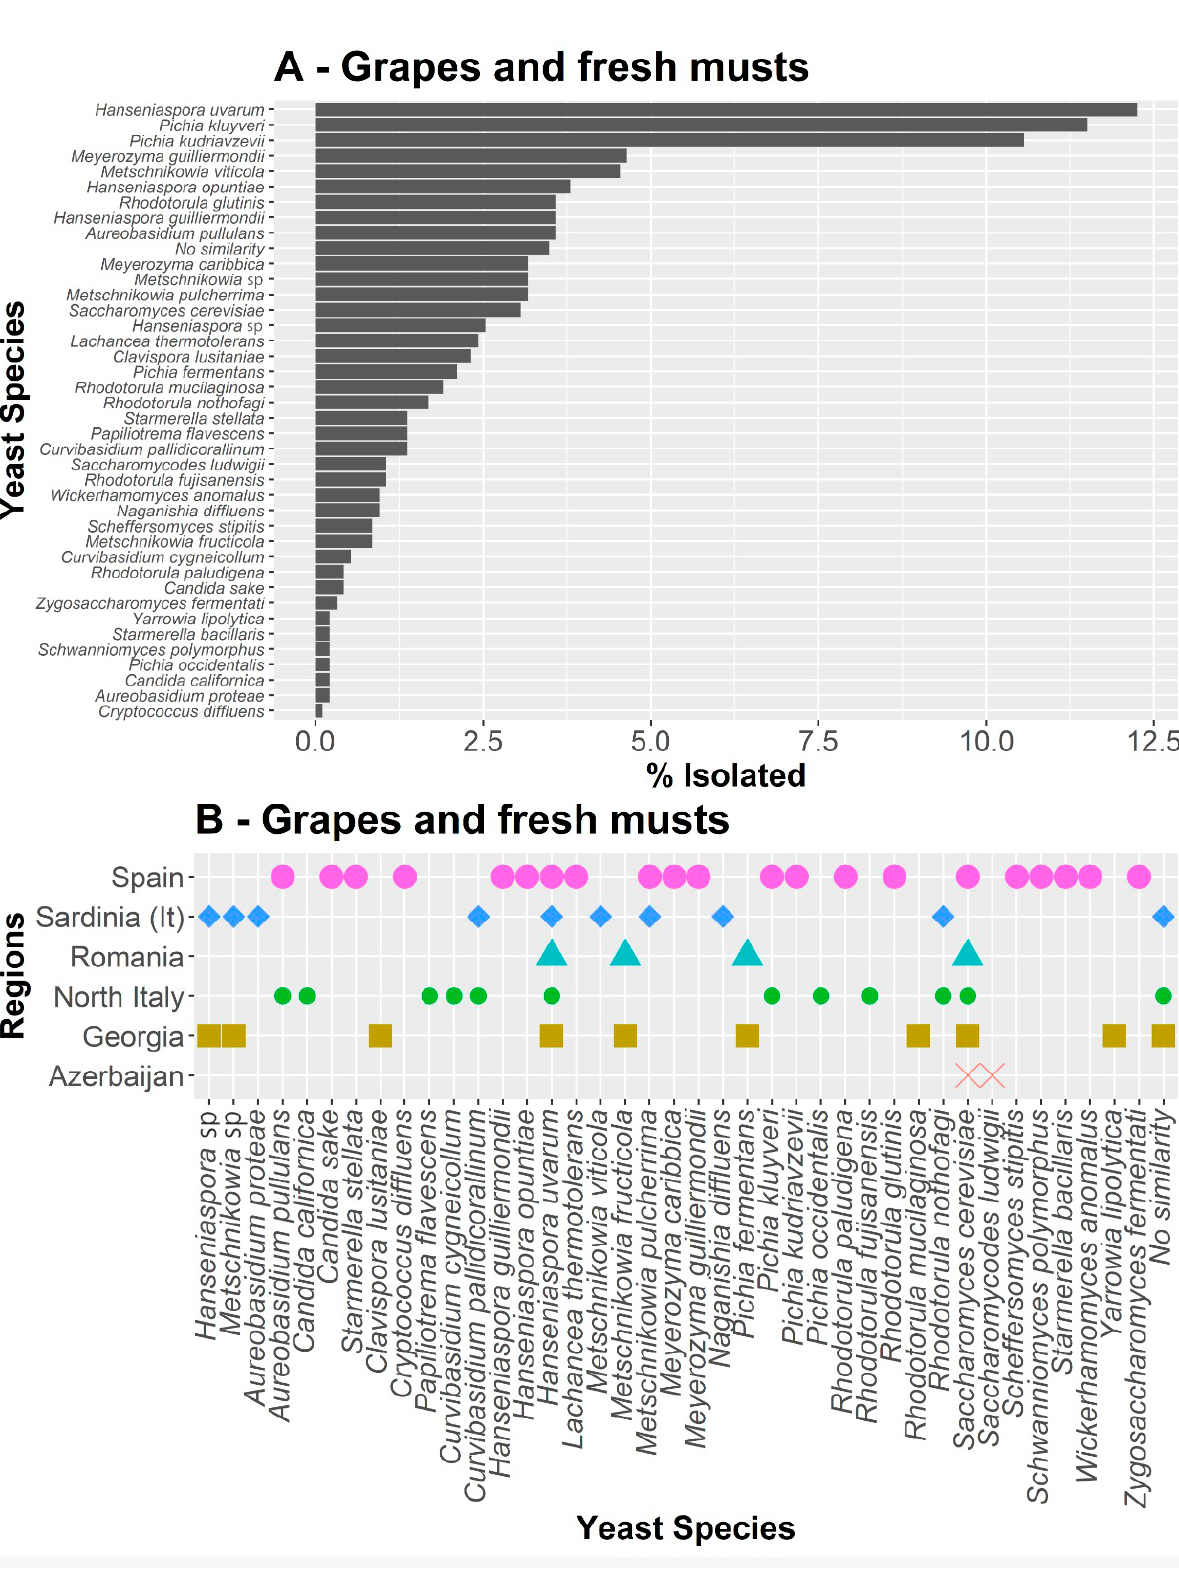
Figure 2. All culturable species isolated from berry skins and fresh musts taken from each location, taking into account both the relative abundance of each species ( A ) and their presence in each region ( B